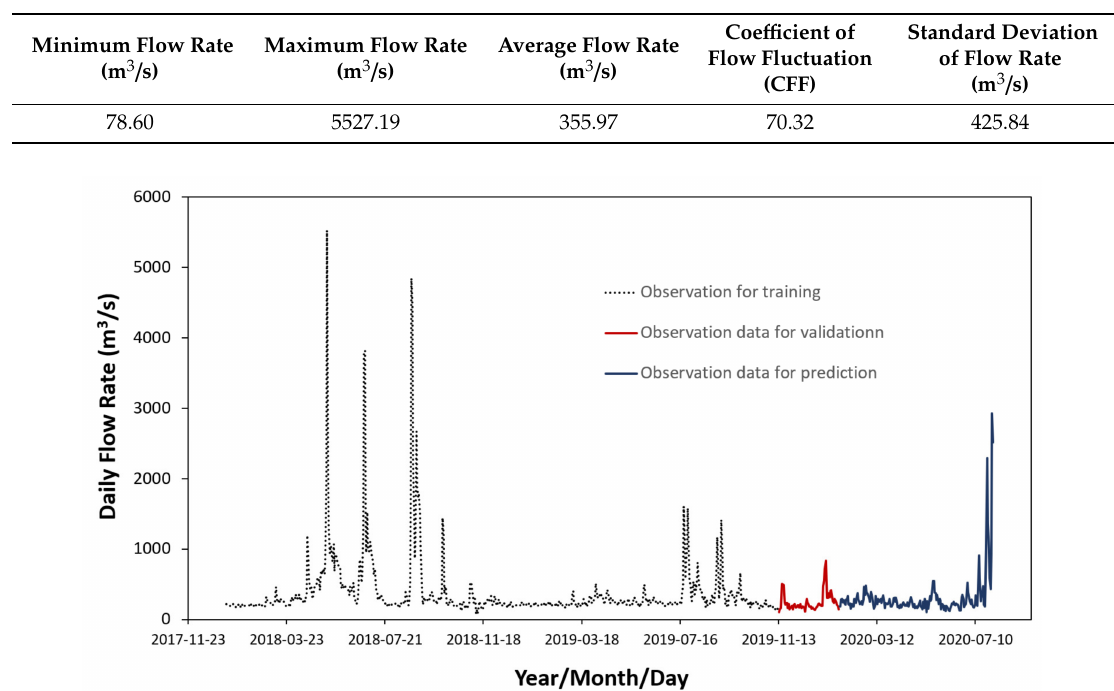
Table 2. Statistical characteristics of daily flow rates at the Hangang Bridge (period: 2018–2020).